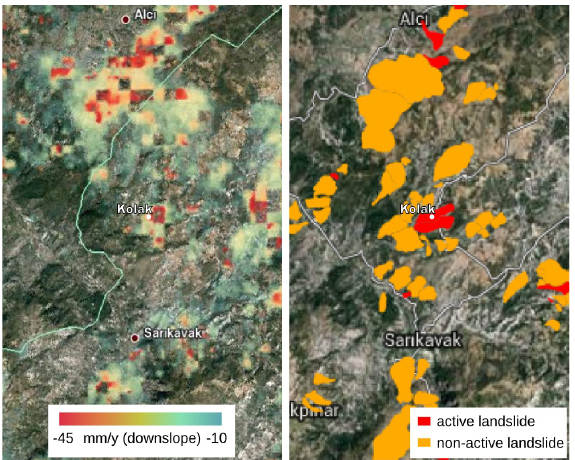
Figure 8. Left: potential landslide activity detected using a basic Sentinel-1 Small Baselines MT-InSAR (based on 26 images between 15/10/2014-14/01/2016). Right: official landslide inventory (MTA Turkey,